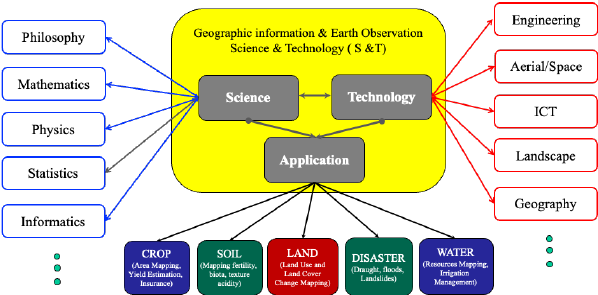
Figure 3 . GSTA Top-down BoK for development of core specialists (modified from DiBasie et al.